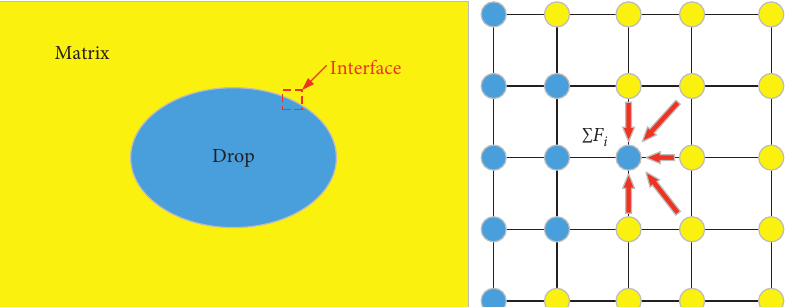
Figure 1: The principle of the pseudopotential model: (a) the schematic of the drop-interface-matrix structure; (b) the pseudopotential force between particles at interface.